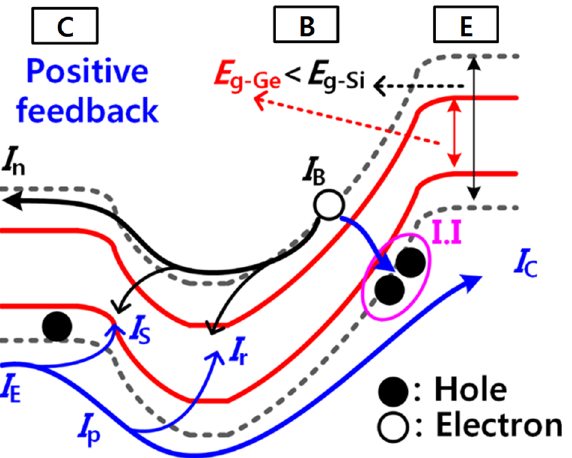
Figure 5. The energy band diagrams along the depth direction of the vertical structure with the different bandgap energies of Ge (red solid line) and Si (gray dashed line). I n is the electron current injected from the base into the emitter, I p is the hole current injected from the emitter into the base, I r is the base recombination current, and I S is another recombination current within the forward-biased emitter-base depleted region.